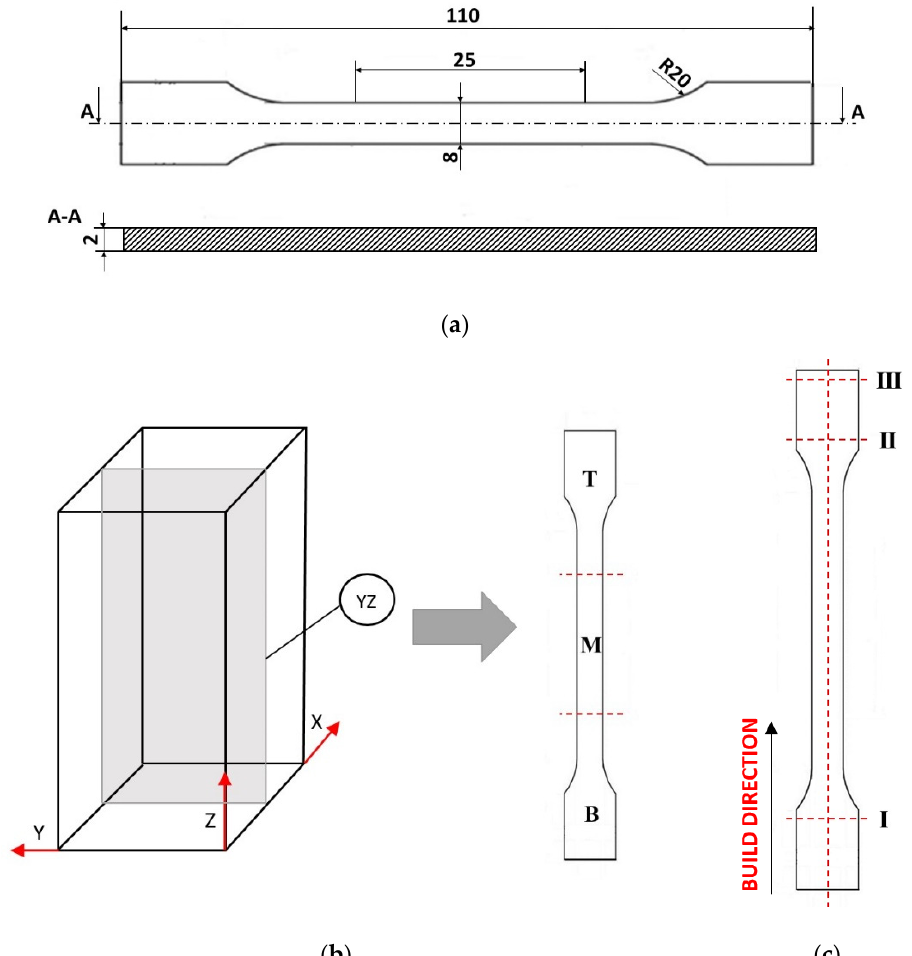
Figure 4. ( a ) Dimension of the tensile samples; ( b ) sample cutting diagram; ( c ) schematic of inden- tations performed for hardness